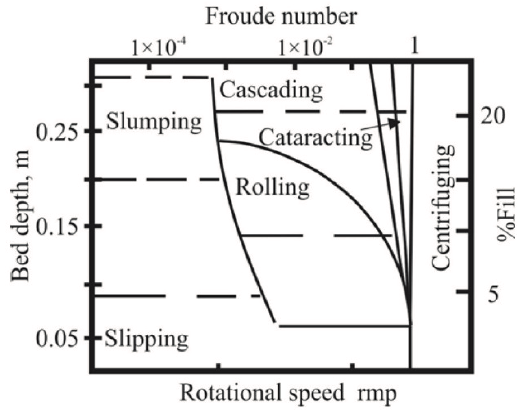
Figure 2. Bed behavior diagram for a rotary kiln indicating particle behavior in relation to rotational speed, bed depth and % fill (adapted from